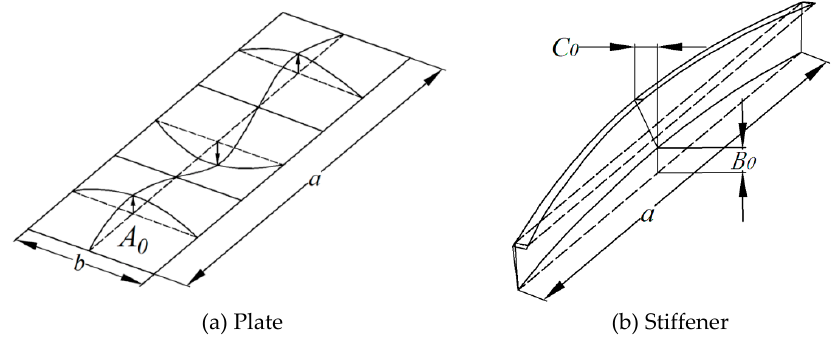
Figure 3. Assumed initial deformation of stiffened plate.